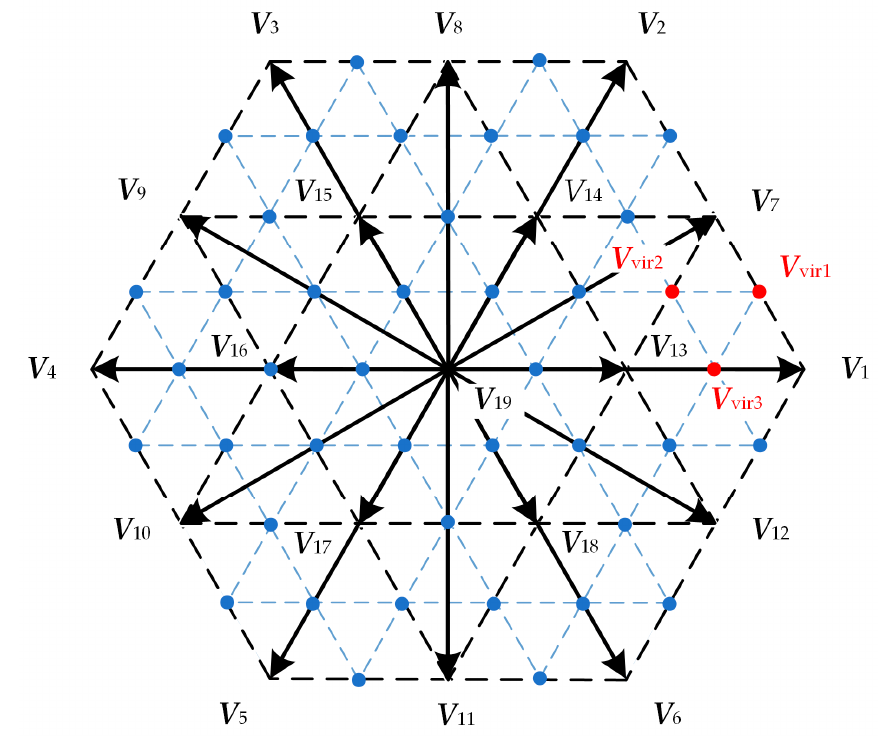
Figure 4. Single-time extension of virtual space vector.